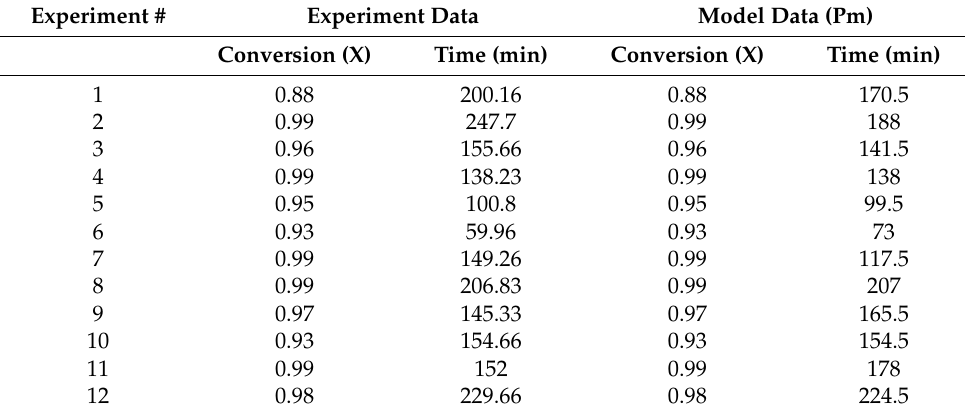
Table A4. Conversion (X) vs. t comparison of model (Pm) and